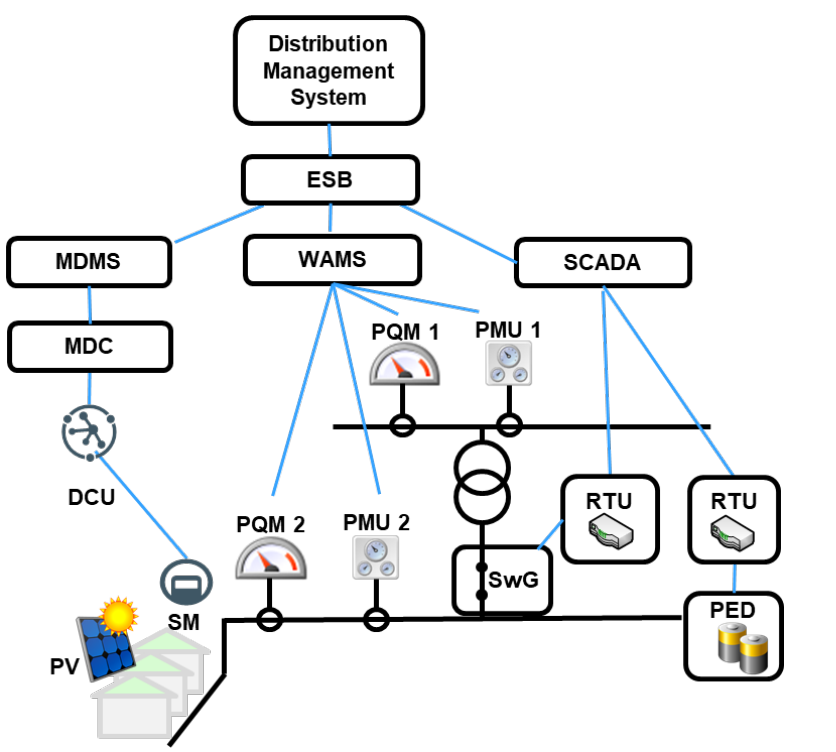
Figure 11. Smart grid and black-out attack use case architecture.